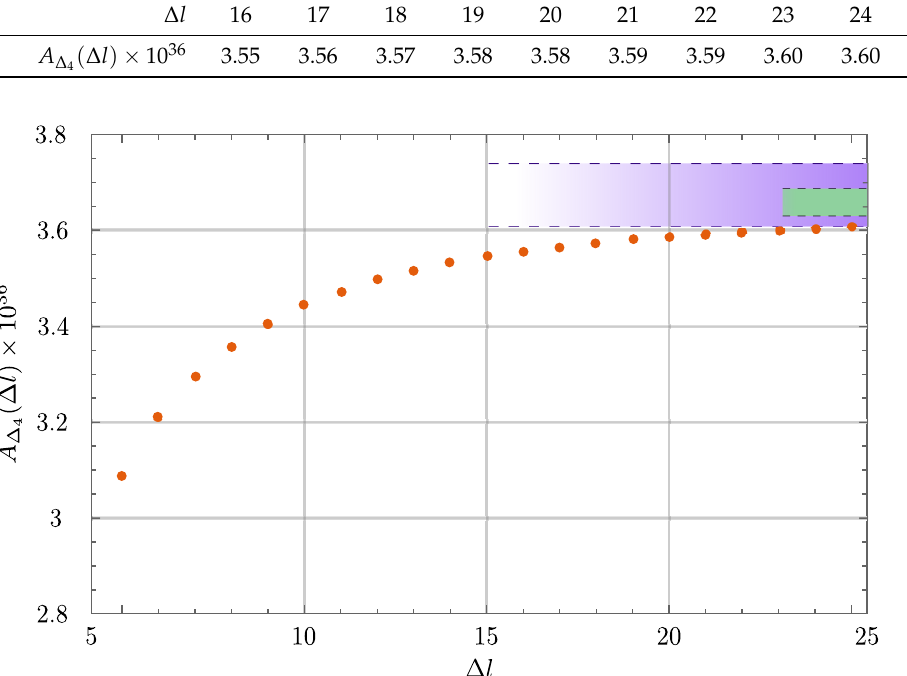
( ∆ l ) in function of the cut-off. 4